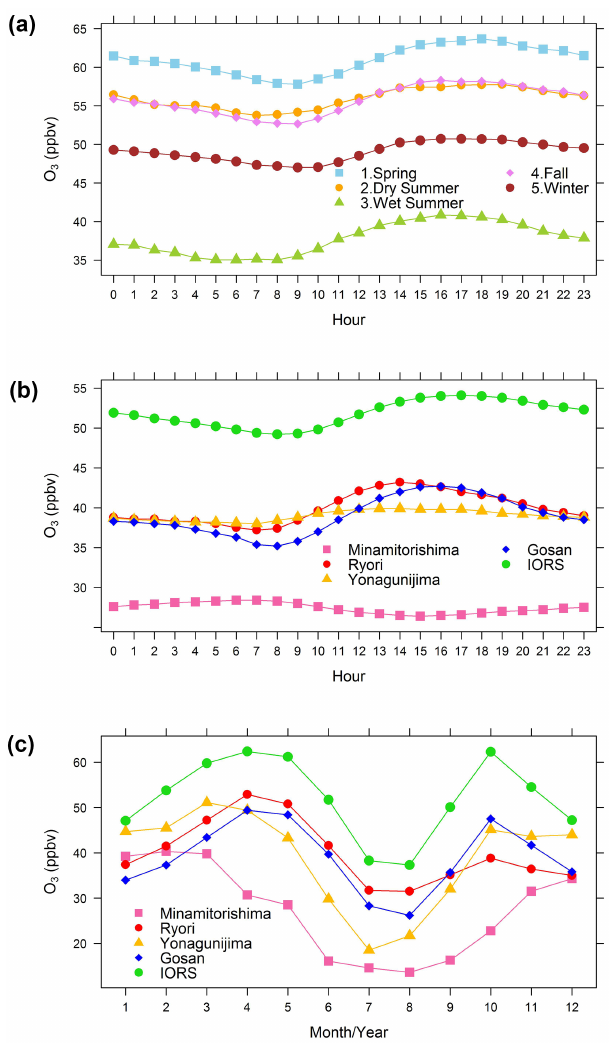
Figure 3. Comparison of diurnal and seasonal variations of O 3 concentrations at remote sites in the northwest Pacific region in- cluding IORS, Gosan, Yonagunijima, Ryori, and Minamitorishima. All data were averaged for 8 years (2003–2010) and seasons were